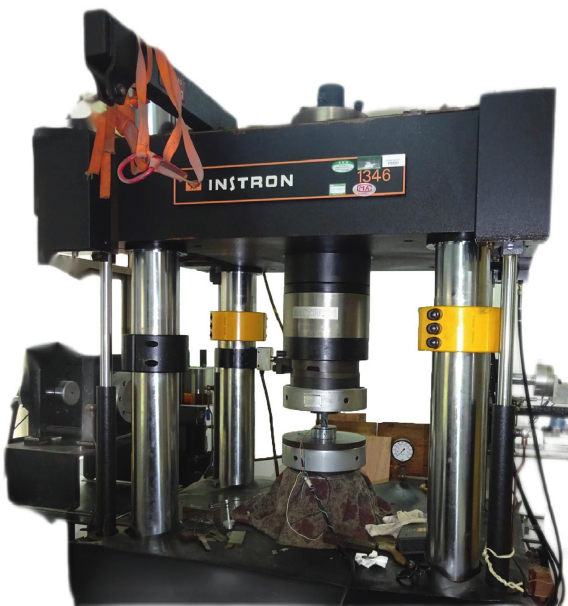
Figure 3: Stress loading